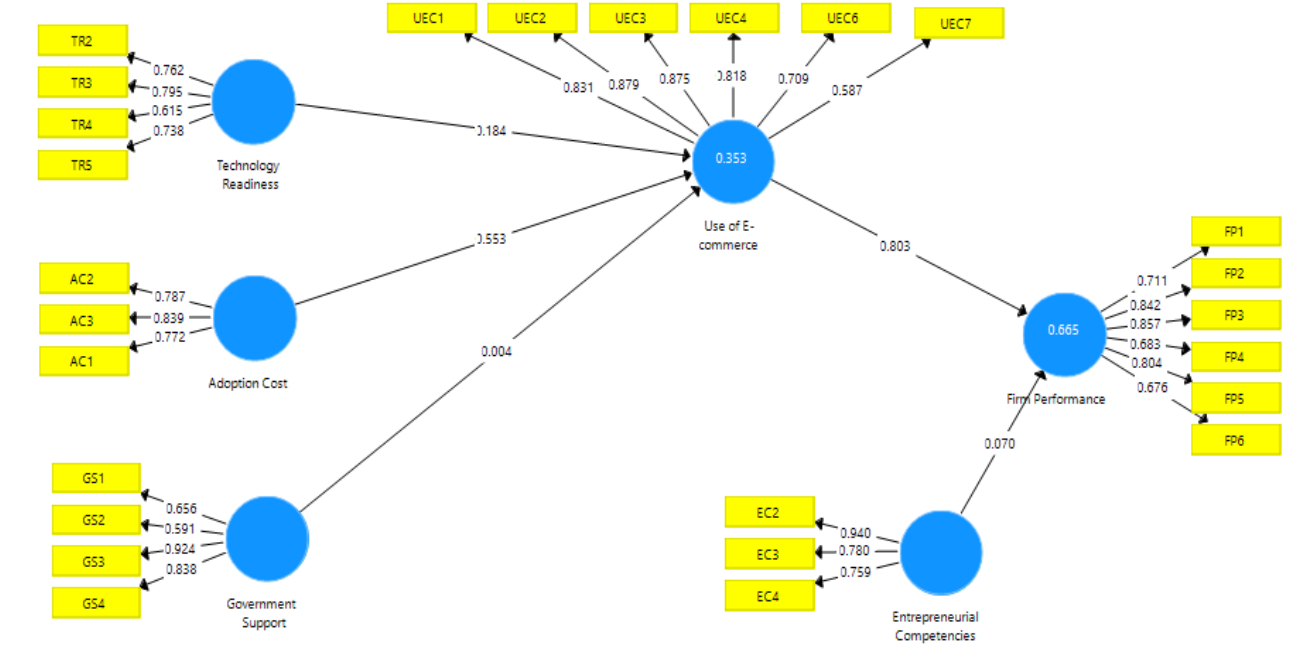
Figure 2. PLS algorithm measurement